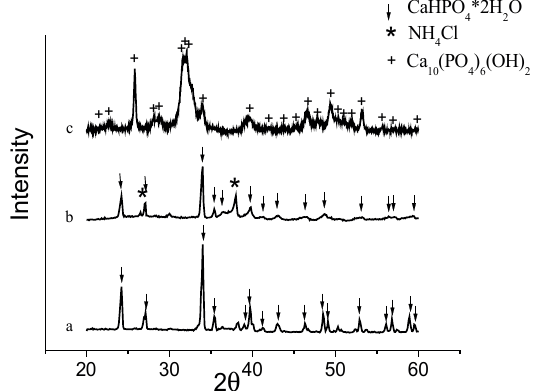
Figure 1. XRD of as-precipitated powders from (NH 4 ) 2 HPO 4 and Ca(NO 3 ) 2 (а), CaCl 2 (b), Ca(CH 3 COO) 2